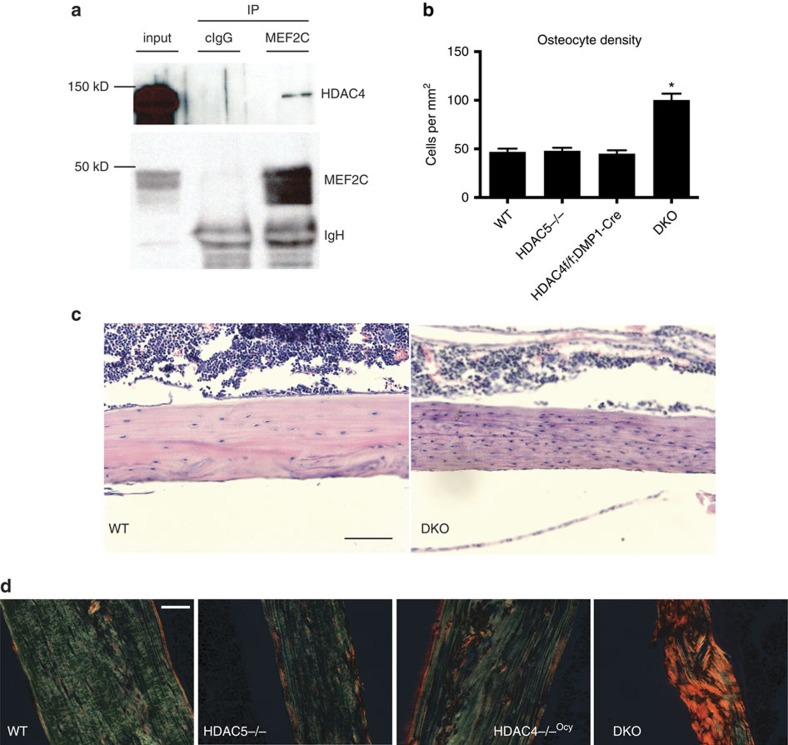
HDAC4 and HDAC5 control osteocyte biology in vivo.(a) Endogenous MEF2C was immunoprecipitated from Ocy454 cells, followed by immunoblotting for the indicated proteins. Data shown are representative of n=3 independent experiments. (b) Osteocyte density in cortical bone 3 mm below the growth plate. 4–5, 8 week old male mice per genotype was analysed, *indicates P<0.01 versus WT by student's unpaired two tailed t-test. (c) Representative H+E section demonstrating increased osteocyte density and disorganized cortical bone in DKO (HDAC4f/f; HDAC5−/−;DMP1-Cre) mice. Scale bar, 40 μm. (d) Sections were stained with Sirius Red and analysed under polarized light to view collagen fibre organization. Disorganized collagen fibers are only seen in DKO sections. Scale bar, 40 μm. Error bars indicate s.e.m for all figures.